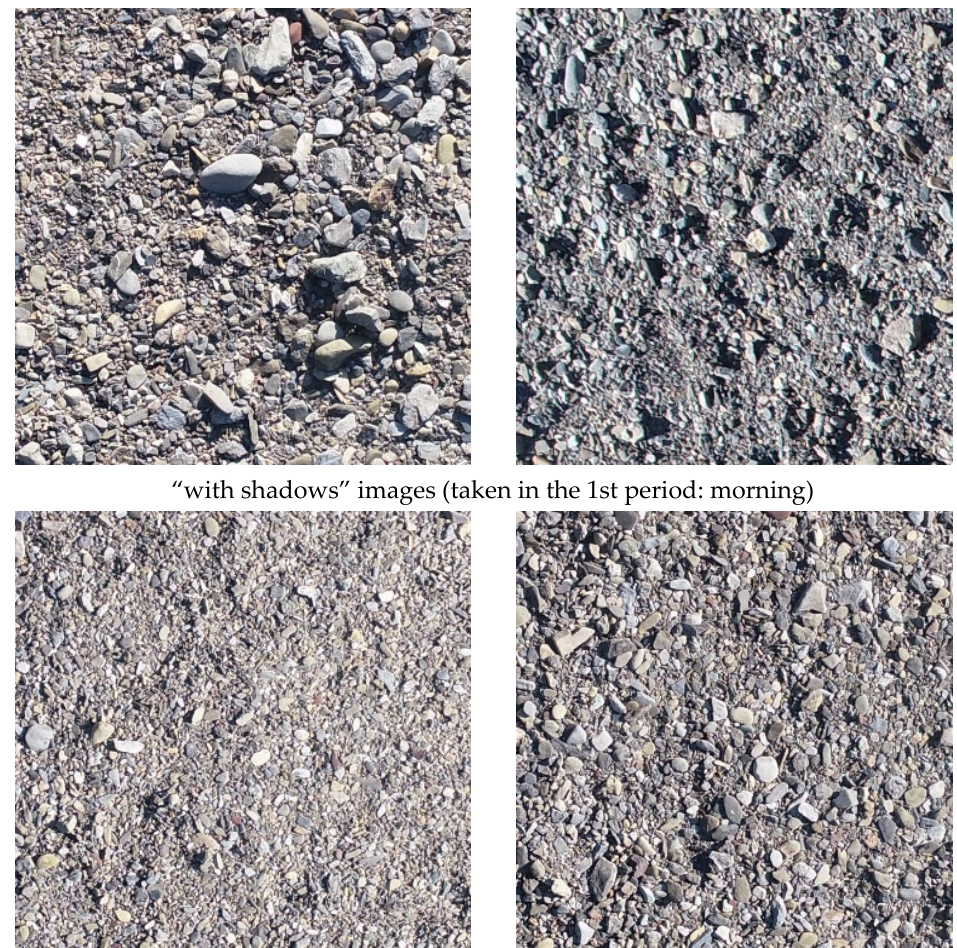
Figure 9. Comparison of the images taken in the 1st and 2nd periods.